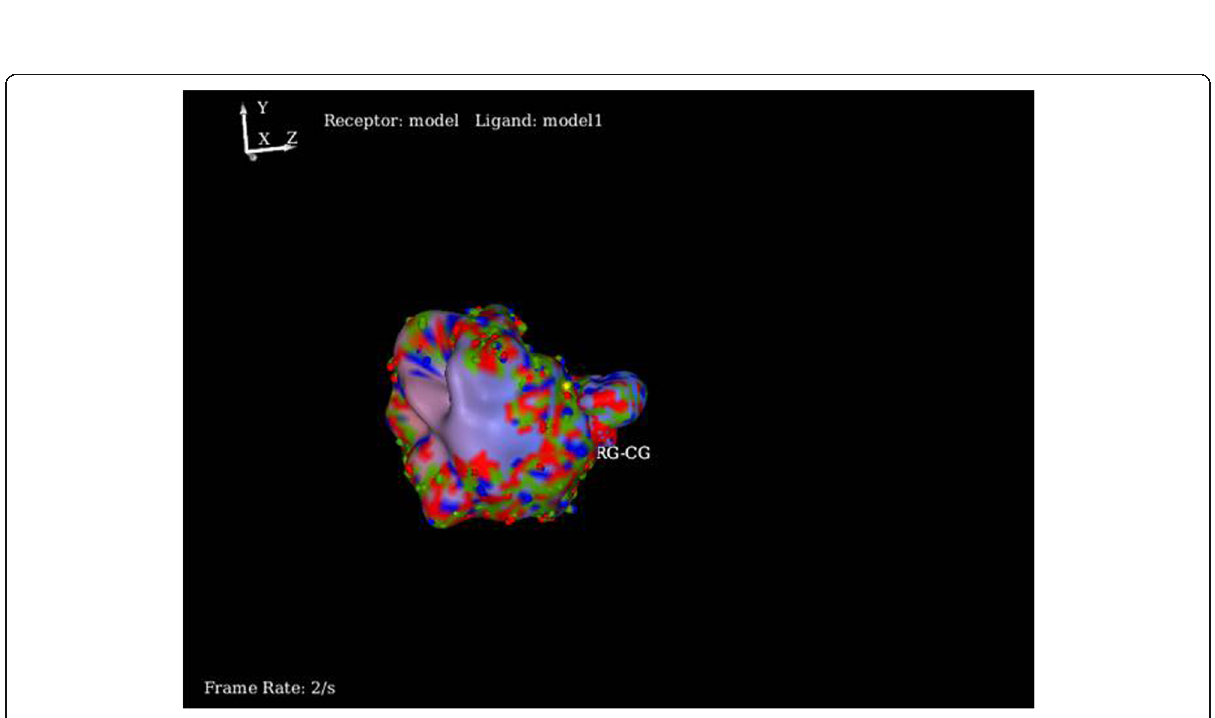
Fig. 8 Interaction between CRM1 (big macromolecule in the left) and NEP of Miami (small macromolecule in the right — RG-CG). The interaction between the two macromolecules demonstrates such a difference in the structural complementarity between